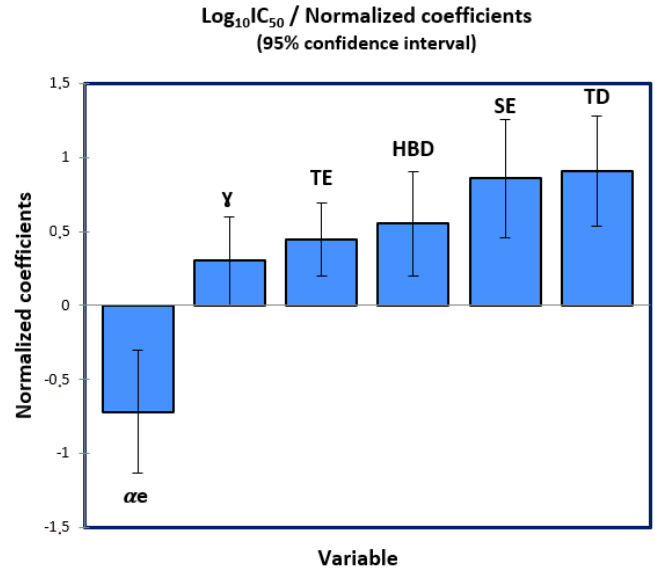
Figure 2. Influence degree of the descriptors on the biological activity. Additionally, the null hypothesis (H0) postulated by the Fisher statistical test is re- jected, because the calculated Fisher value ( F = 10.325) is so much higher than its critical value: [ F (35,6) = 2.37, p < 0.0001], as presented in the one Anova test (Table 3). Therefore, the variance between the response (Log 10 IC 50 ) and the six predictor variables is homoge- neous. Moreover, the correlation and determination coefficients of R = 0.83 and R 2 = 0.69, respectively, confirm that there is a strong relationship between the descriptors and the inhibitory activity. Thus, the first QSAR model generated via MLR technique has a good predictive performance, with a low standard error ( RMSE = 0.66). Table 3. Variance analysis.